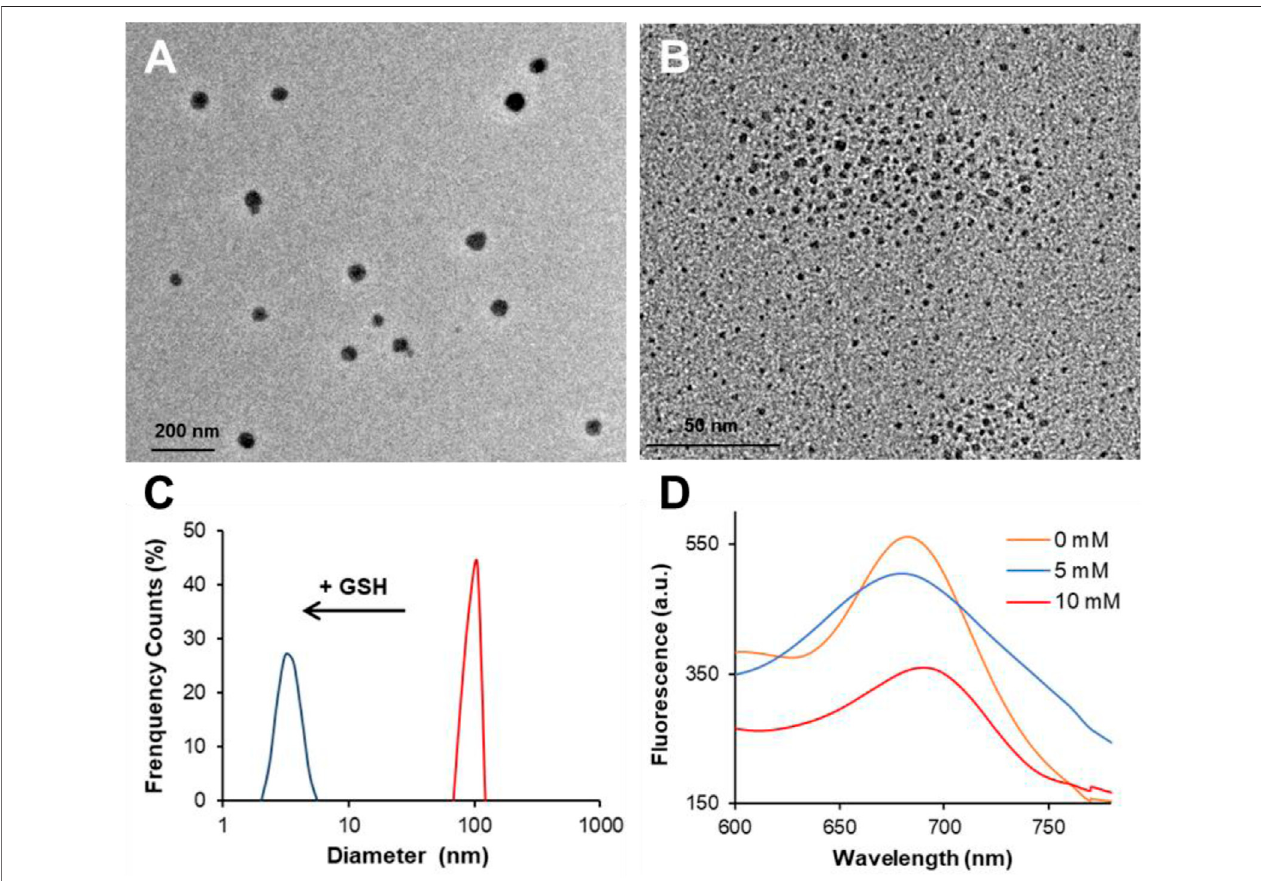
FIGURE3| Transmissionelectronmicroscopy(TEM)imagesofLGNCaggregatesbefore (A) andafter10-mMGSHtreatment (B) .Thehydrodynamicsizevariation of LGNCs with and without GSH (C) . The fl uorescent spectra of LGNCs after GSH treatment at different concentrations (D) .